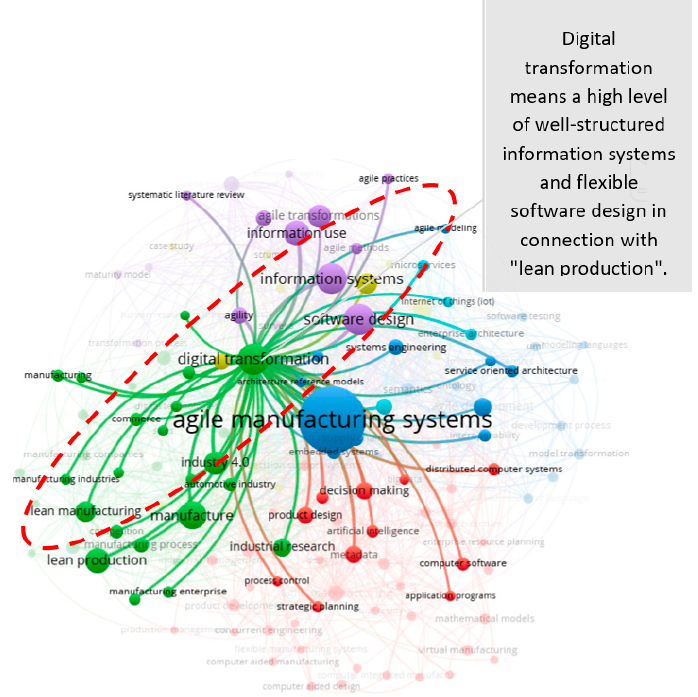
Figure 7. VOSviewer: Digital transformation focus of agile manufacturing systems.